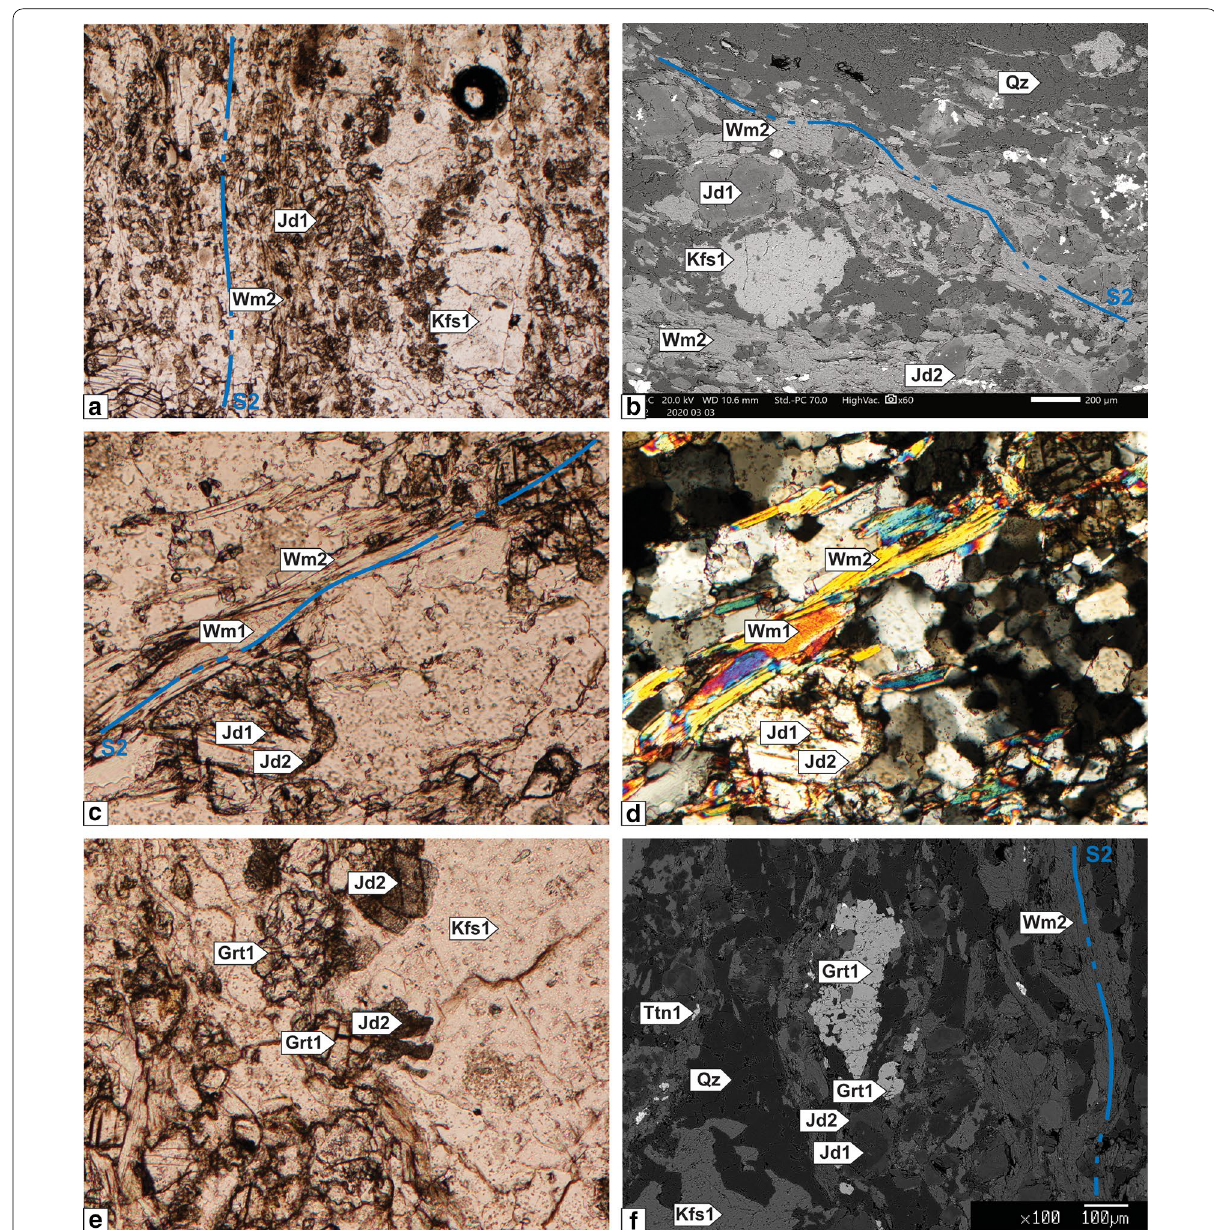
Fig. 6 Microstructures in orthogneisses (ZR19). a Kfs1 porphyroclast wrapped by S2 marked by Wm2 and Jd1. Plane polarized light. Long side of the microphotograph 3.3 mm. b Back-Scattered Electron (BSE) image showing Kfs1 porphyroclast wrapped by S2 marked by Wm2 and Jd1. Jd1 = is rimmed by lighter Jd2. c Jd1 crystal rimmed by Jd2 and Wm1 crystals at very low angle to Wm2 underlying the S2 foliation. Plane polarized light. Long side of the microphotograph 0.86 mm. d Crossed polar image of photograph c. Wm1 crystals show undulose extinction and transverse LPO = with respect to S2. Long side of the microphotograph 0.86 mm. e Large Kfs1 porphyroclast with Grt1 and Jd2 crystals at the rim. Plane polarized = light. Long side of the microphotograph 0.86 mm. f Back-Scattered Electron (BSE) image showing Grt1 and Jd1 crystals wrapped by the S2 = foliation marked by Wm2, Jd2, Ttn1 and smaller Grt1